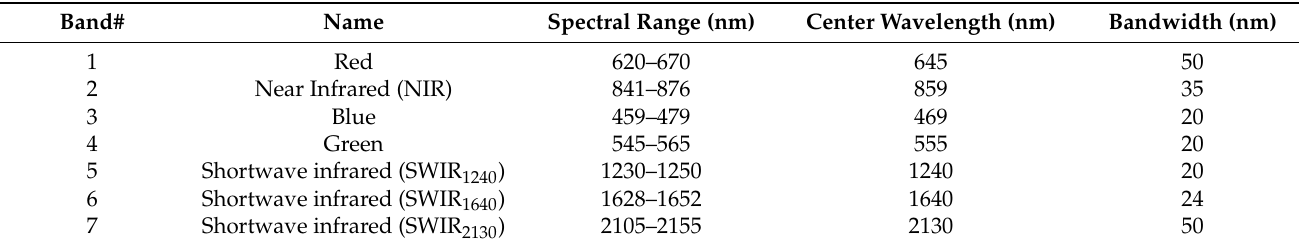
Table 1. The spectral characteristics of MOD09A1